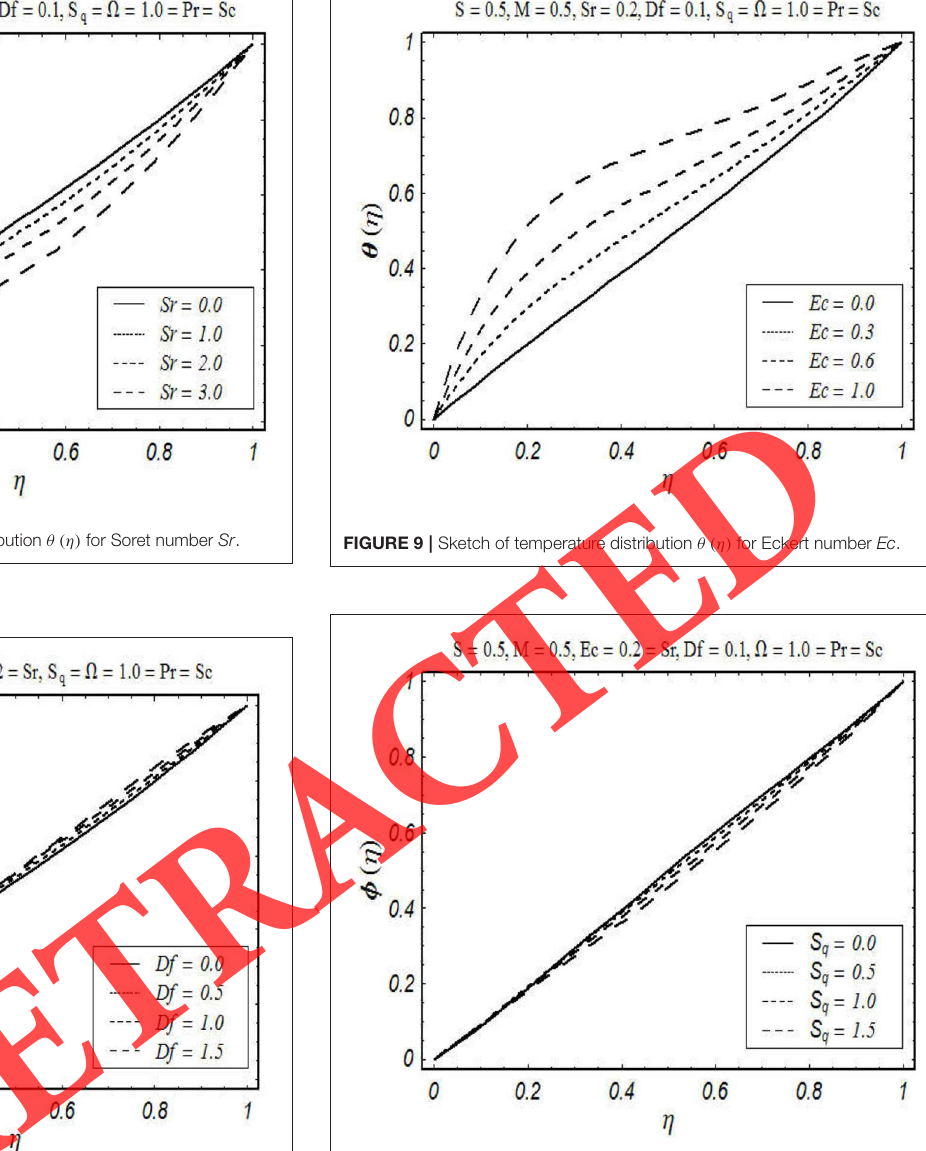
FIGURE 10 | Sketch of concentration distribution φ (η) for squeezing number S q